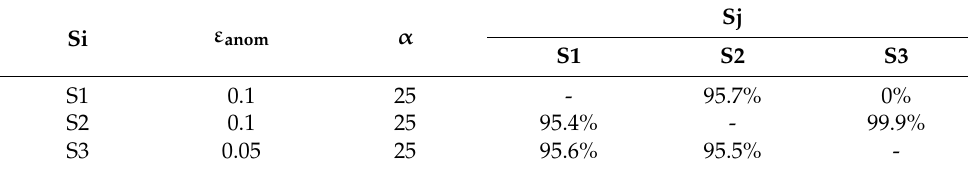
Figure 8. SS-AD: false positive detection. Table 3. SS-AD: best configuration and anomaly detection accuracy.